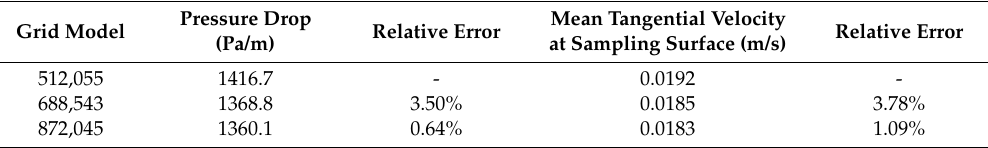
Table 2. Grid independence tests.